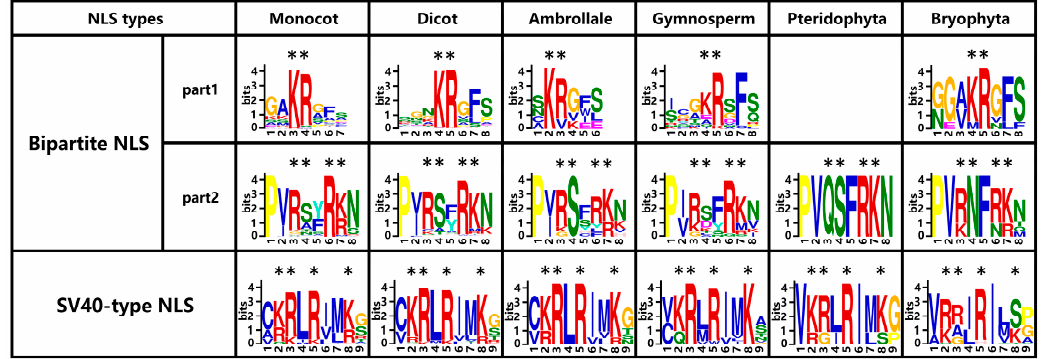
Figure 7. Presence of conservative amino acids in the nuclear localization signal (NLS) of Aux/IAAs. The content of conservative amino acids is expressed by the height of characters. The amino acids under the symbol * are conservative NLS sites. Table 3. The amino acid compositions of Aux/IAA NLSs in plants.